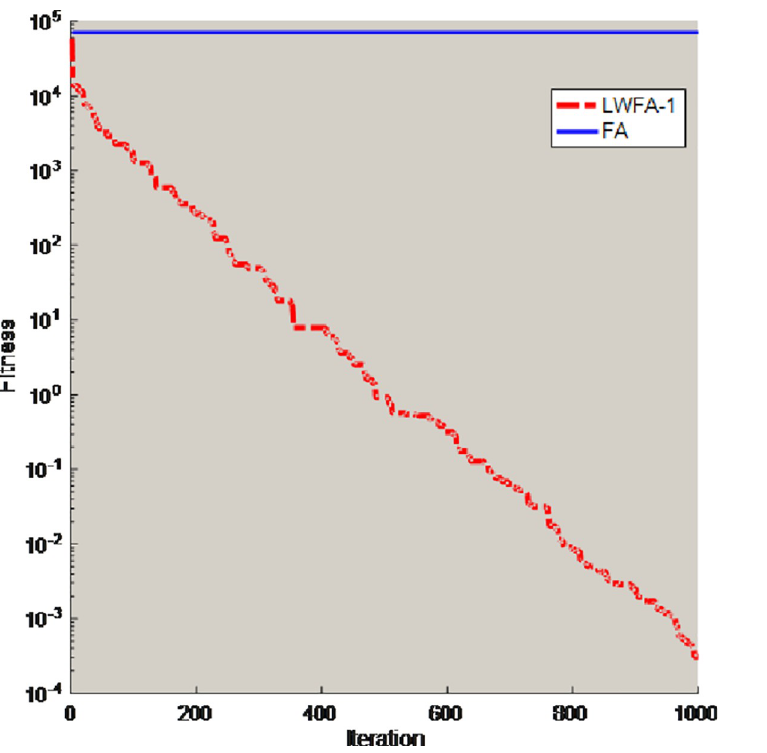
Fig 2. Convergence curves of unimodal functions f 2